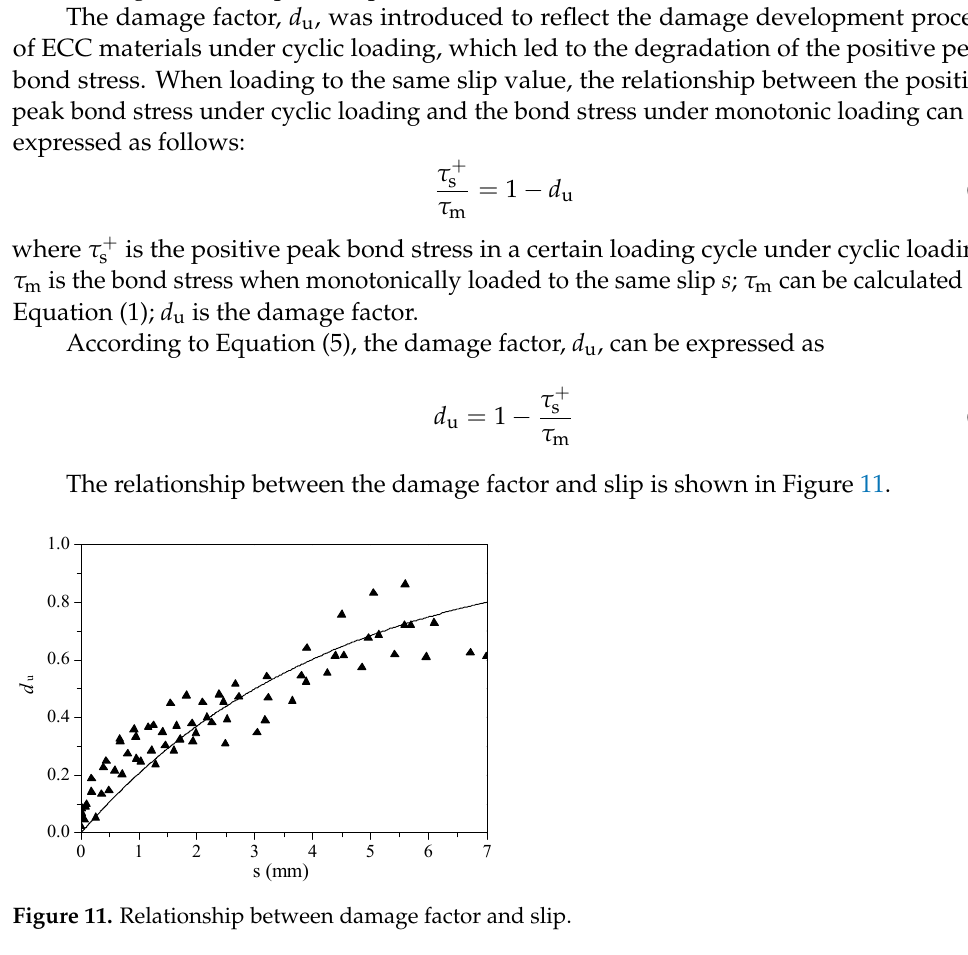
Figure 10. A schematic diagram of the bond–slip relationship under cyclic loading.